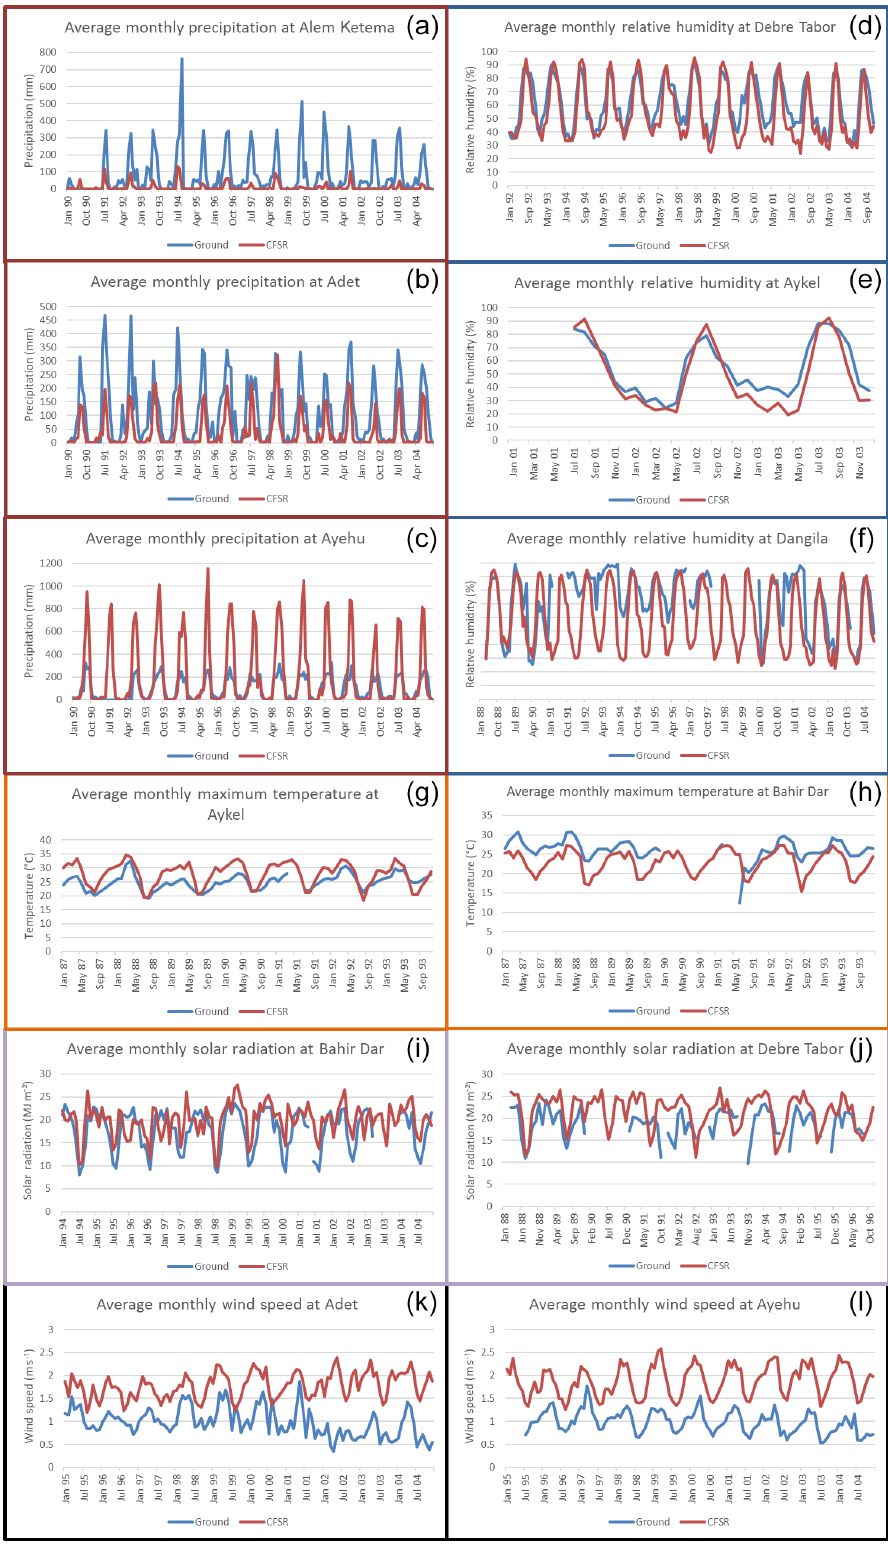
Figure 5. Comparisons between the ground and CFSR weather datasets. Panels (a–c) are average monthly precipitation; (d–f) are average monthly relative humidity; (g, h) are average monthly maximum temperatures; (i, j) are average monthly solar radiation; and (k, l) are average monthly wind